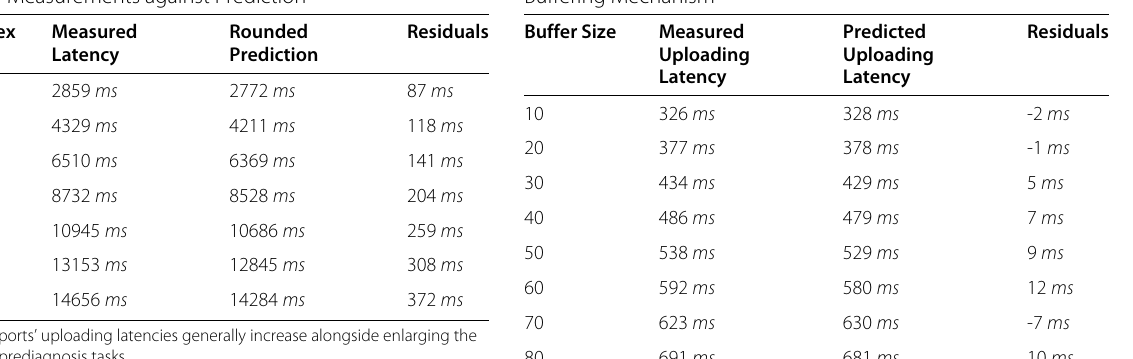
Table 5 Validation of the Uploading Latency Model under